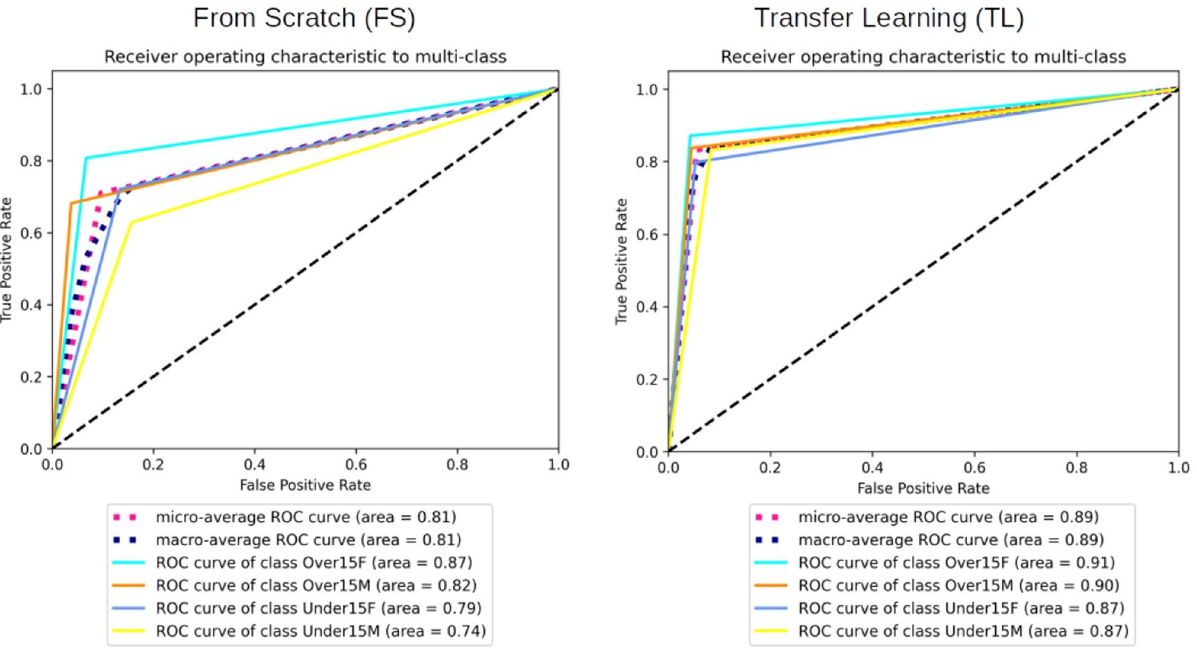
Figure 5. Receiver Operating Characteristic (ROC) curves to MultiClass analyses using DenseNet121 with From Scratch (FS) and Transfer Learning (TL)